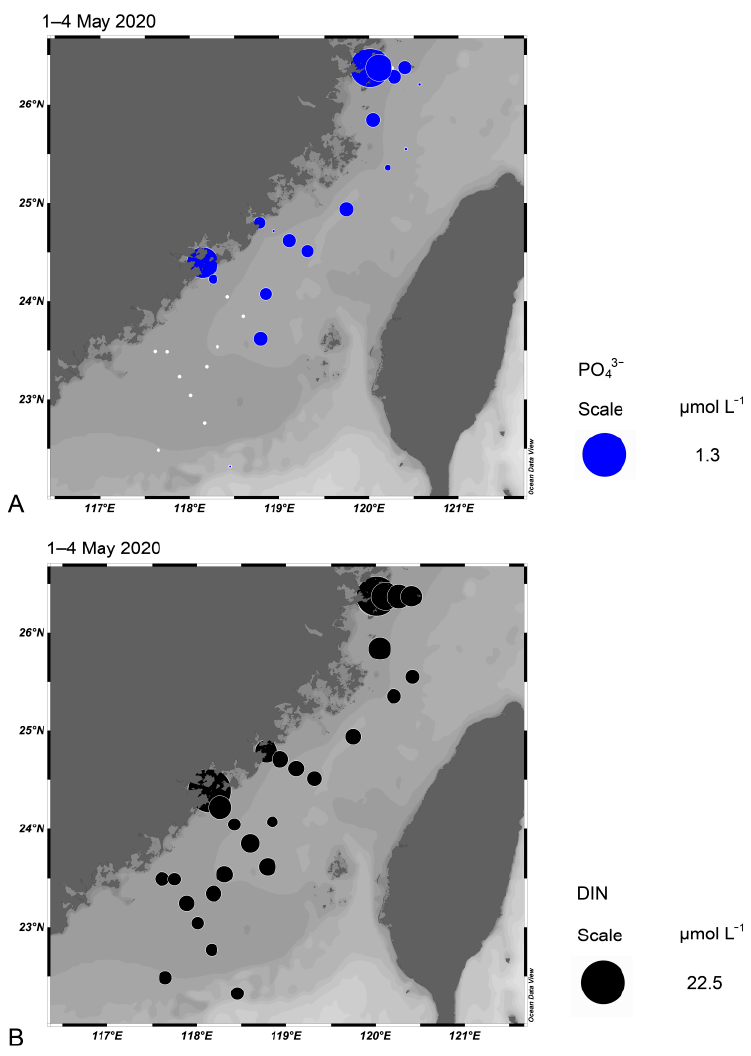
Figure 10. Concentration ( µ M) of ( A ) PO 43 − and ( B ) DIN (NO 2 − , NO 3 − , and NH 4+ ) in water samples collected in the Taiwan Strait in May 2020.